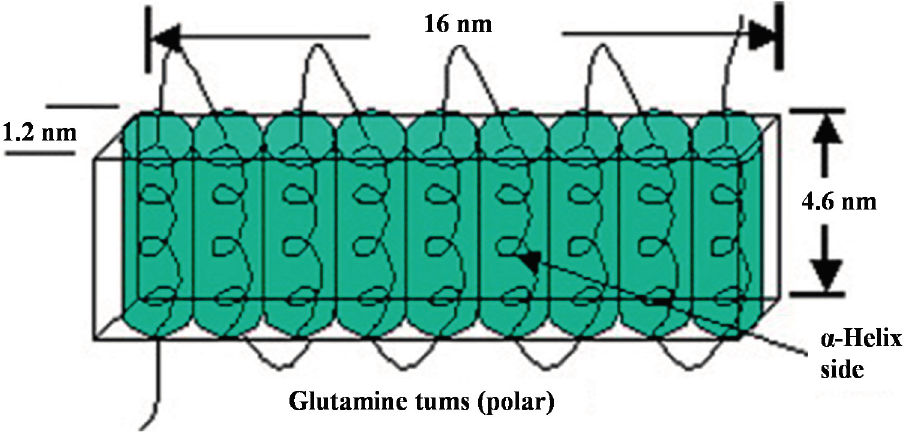
Figure 2. A possible structural model for α - zeins (Z22). Each of the tandem repeat units formed by a single α -helix is presented by the cylinder and glutamine-rich “turns” or loops joining them by the curve. The anti-parallel helices of tandem repeats stack linearly in the direction perpendicular to the helical axis (the c -axis). Reprinted with permission from [5,33]. Copyright 2008,